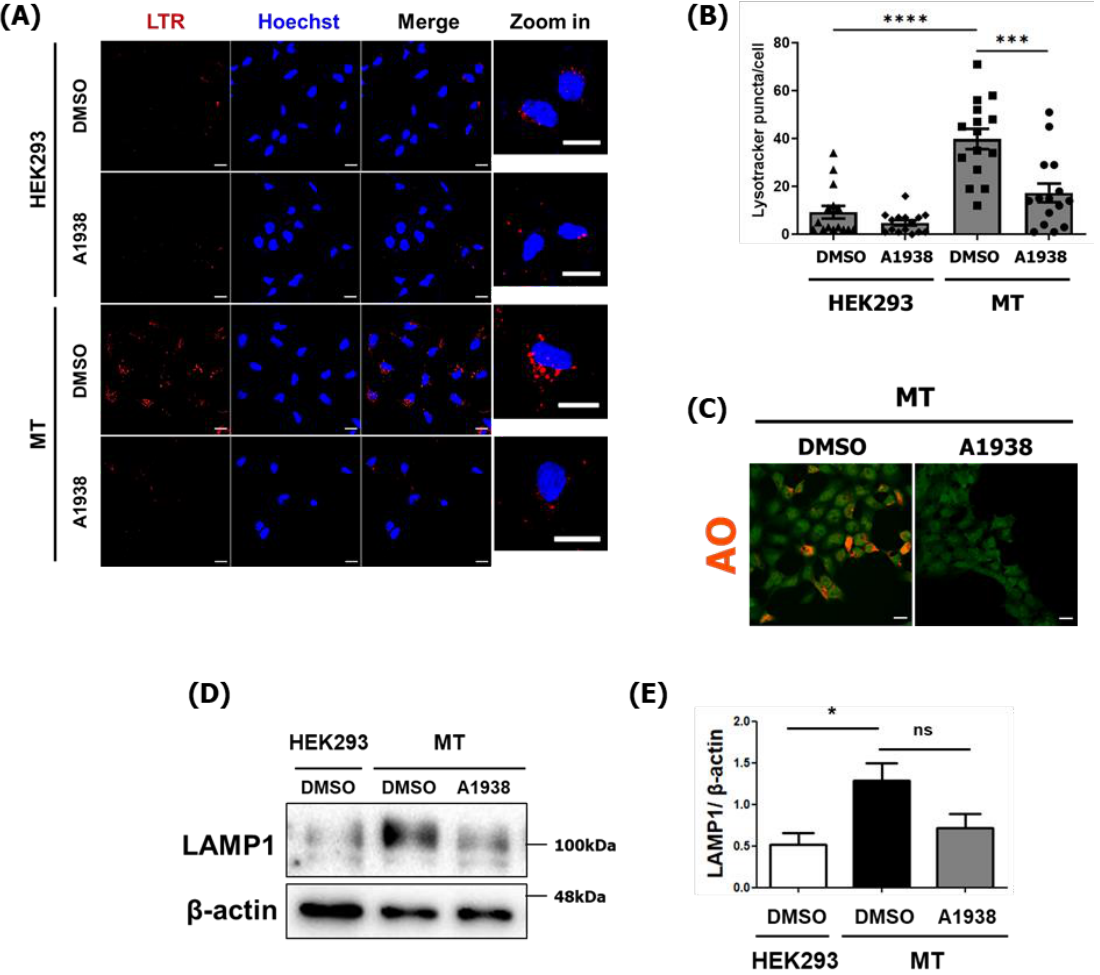
Figure 4. Lysosome activity in MT cells with or without A1938 treatment. ( A ) Confocal microscopy images and ( B ) numbers of acidic lysosome red puncta were counted in HEK293 and MT cells ( n = 15). The cells were treated with DMSO as a control or 30 µM A1938 for 24 h and then stained with LTR. Scale bar, 20 µm. ( C ) Confocal microscopy images of MT cells treated with DMSO as a control or 30 µM A1938 for 24 h, then the live cells were stained with 2 µg/mL acridine orange for 25 min and fixed. Scale bar, 20 µm. ( D ) Images of HEK293 and MT cell extracts treated with the DMSO control or 30 µM A1938 for 24 h in a serum-free medium, then subjected to Western blot analysis using antibodies against LAMP1. ( E ) Intensities of the LAMP1 immunoblot bands were normalized to β -actin expression. Western blot analysis out of three independent experiments. Statistical signif- icanc e was assessed using Student’s t -test. ns, p > 0.05, * p < 0.05, *** p < 0.001, **** p < 0.0001.